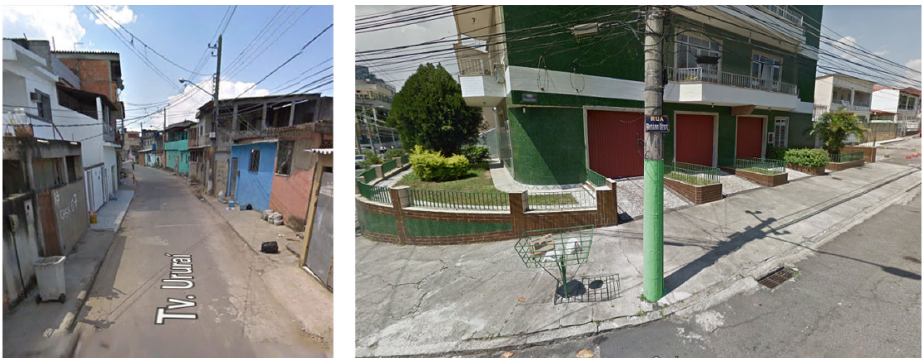
Figure 4. Difference between the constructive standards of a “favela” (left image—located in Area 3) and regular occupations (right image—located in Area 1). Source: Street View (Google). and regular occupations (right image—located in Area 1). Source: Street View